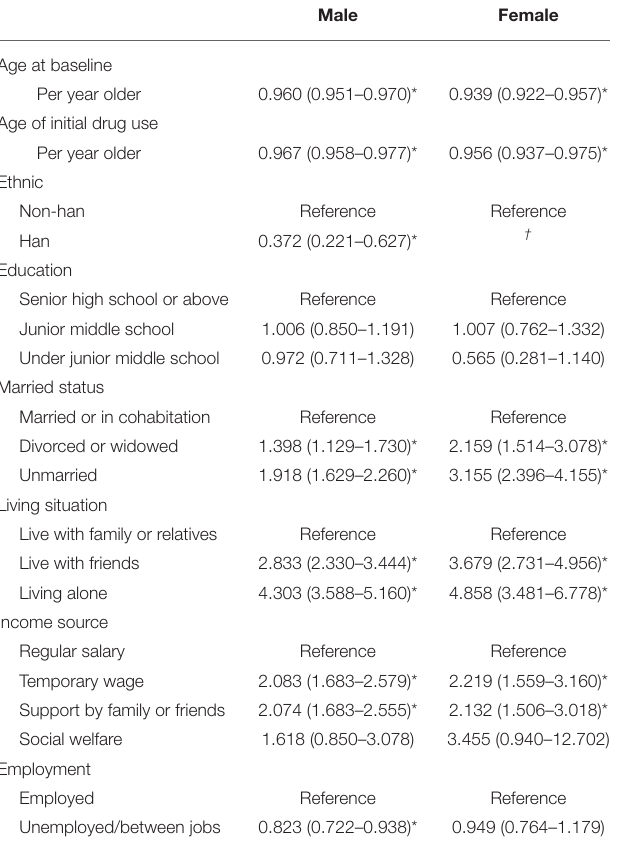
TABLE 5 | Multivariable GEE analyses of factors associated with multiple sex partners in the last 3 months among PWUD on MMT in Wuhan, China,